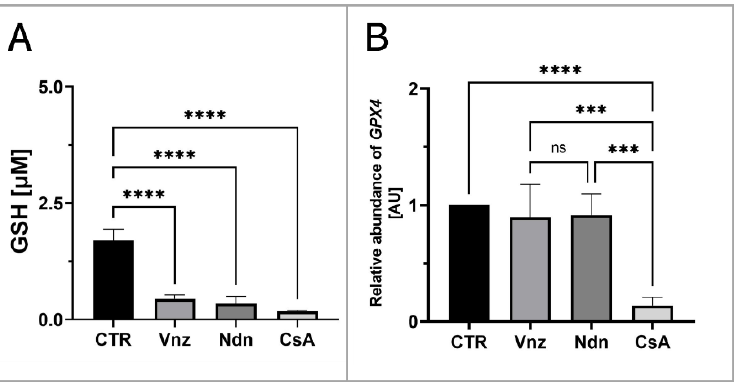
Figure 8. Quantitative analysis of intracytoplasmic glutathione concentration ( A ) and GPX4 gene ( B ) shown by RT-qPCR at the transcript level in porcine COCs subjected to the IVM procedure using a 3D culture model (alginate capsules) in control cultures (CTR) or in experimental cultures: in the presence of vinclozolin (Vnz), nandrolone (Ndn) or cyclosporin A (CsA). The results are presented as mean values with n = 5 ± standard deviation (SD), and each “ n ” consisted of 50 COCs. Statistical analysis: homogeneity of variance—Brown–Forsythe test; normality of distribution—Bartlett’s test and one-way ANOVA followed by Dunnett’s post hoc test, *** p < 0.001, **** p < 0.0001; ns—nonsignificant.